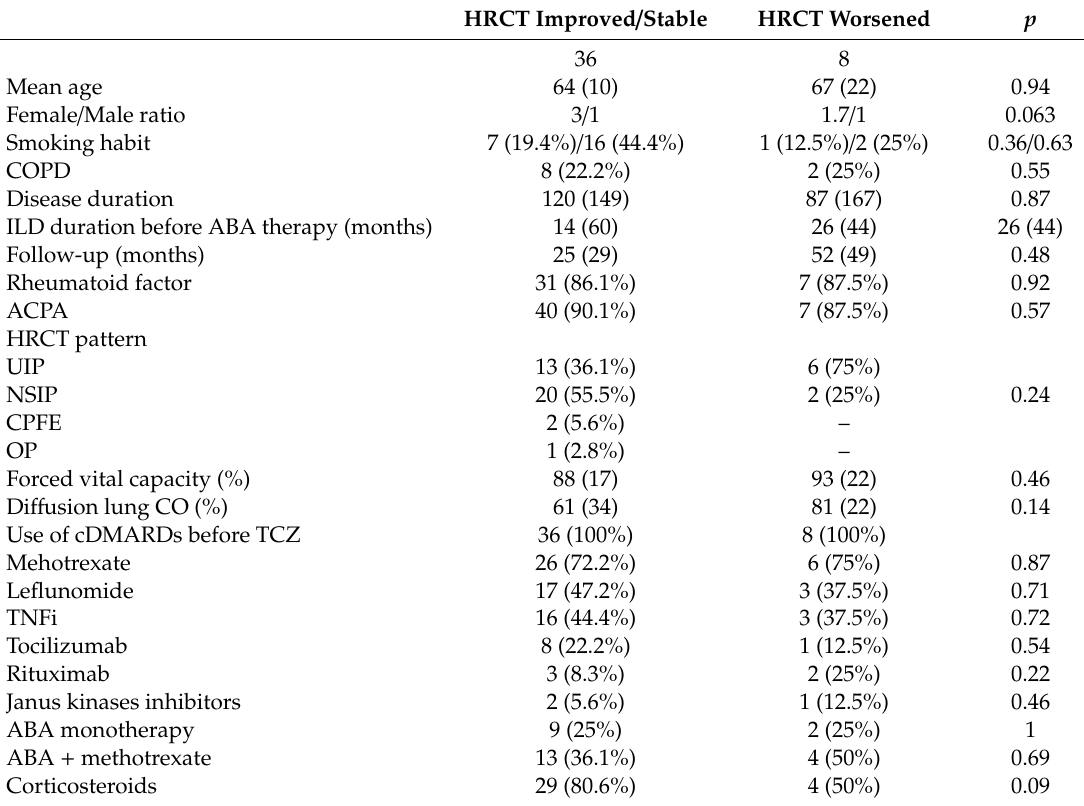
Table 2. Demographic, clinical, and serological features of patients at baseline according to their HRCT outcome. HRCT Improved / Stable HRCT